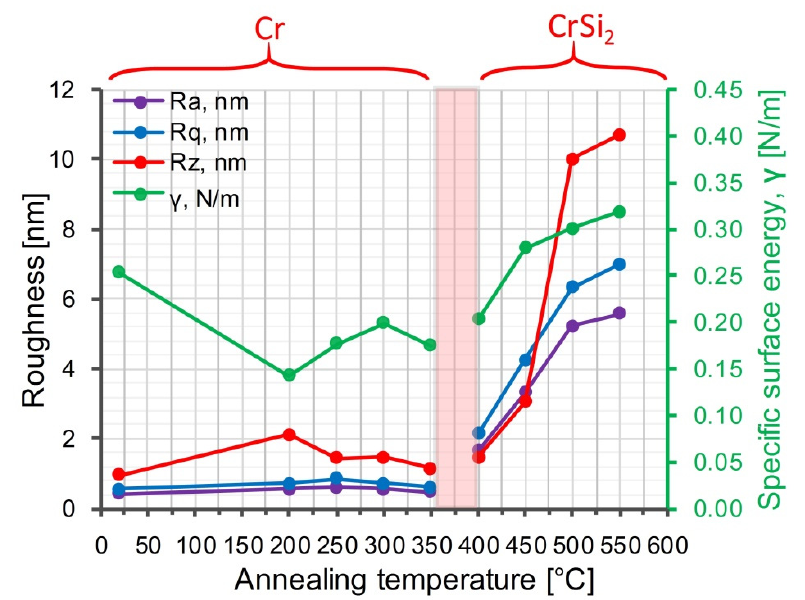
Figure 6. Dependences of the roughness parameters Ra , Rq and Rz and the specific surface energy of the Cr/Si structure on the rapid thermal treatment temperature.